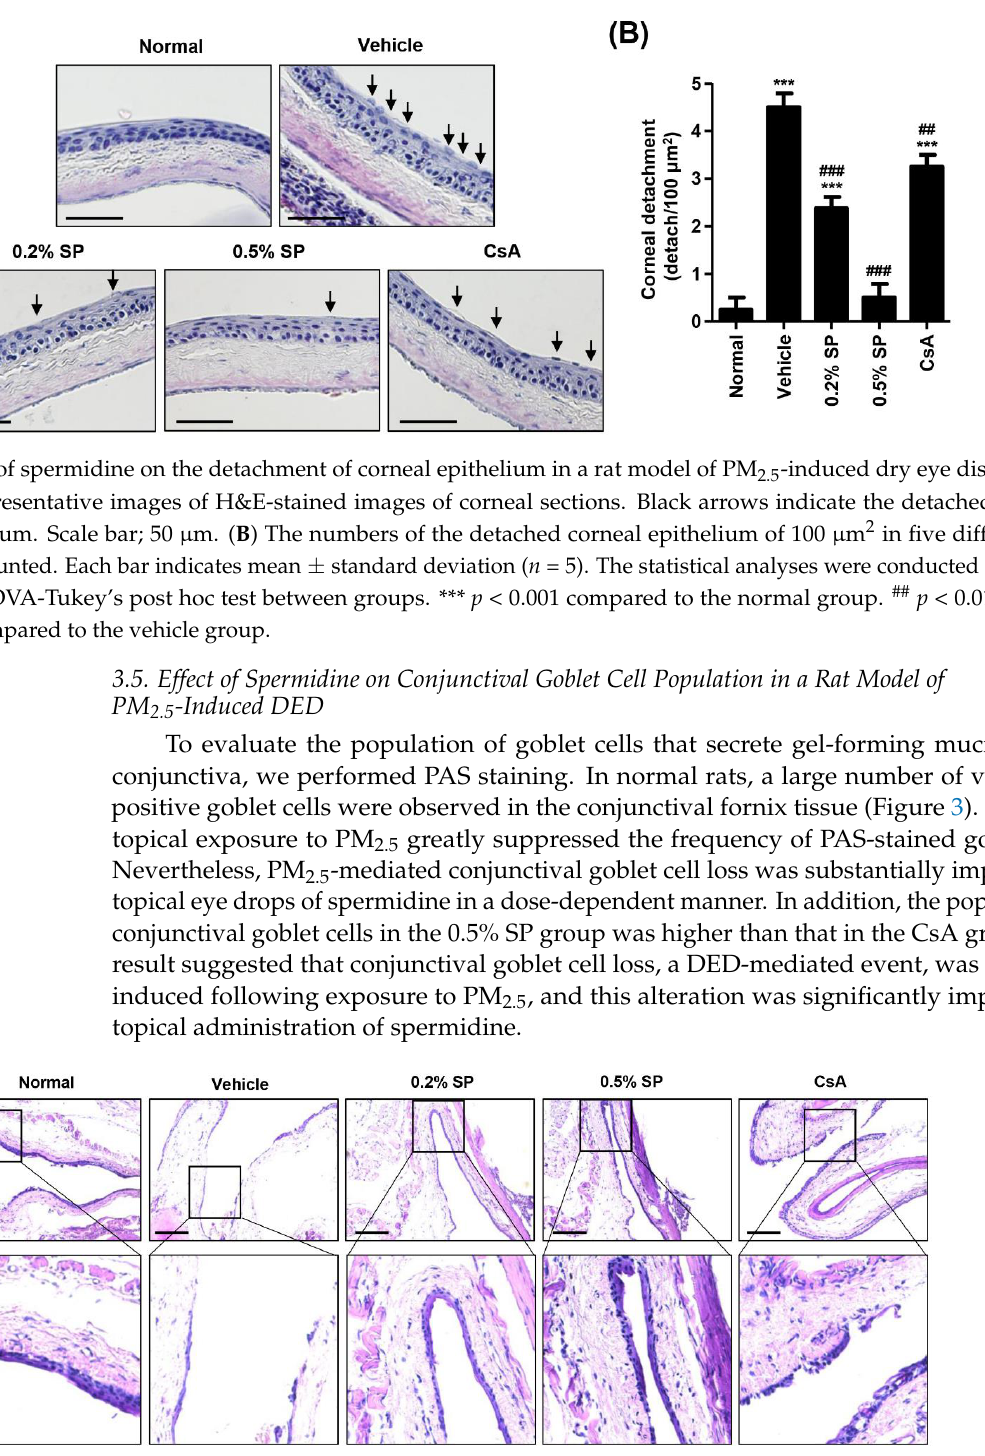
Figure 3. Effect of oral administration of CFW on conjunctival fornix goblet cell population in a rat model of PM 2 . 5 -induced DED. Representative images of PAS-stained images of conjunctival fornix sections. The goblet cells that stained a strong violet color. Scale bar; 100 μm.